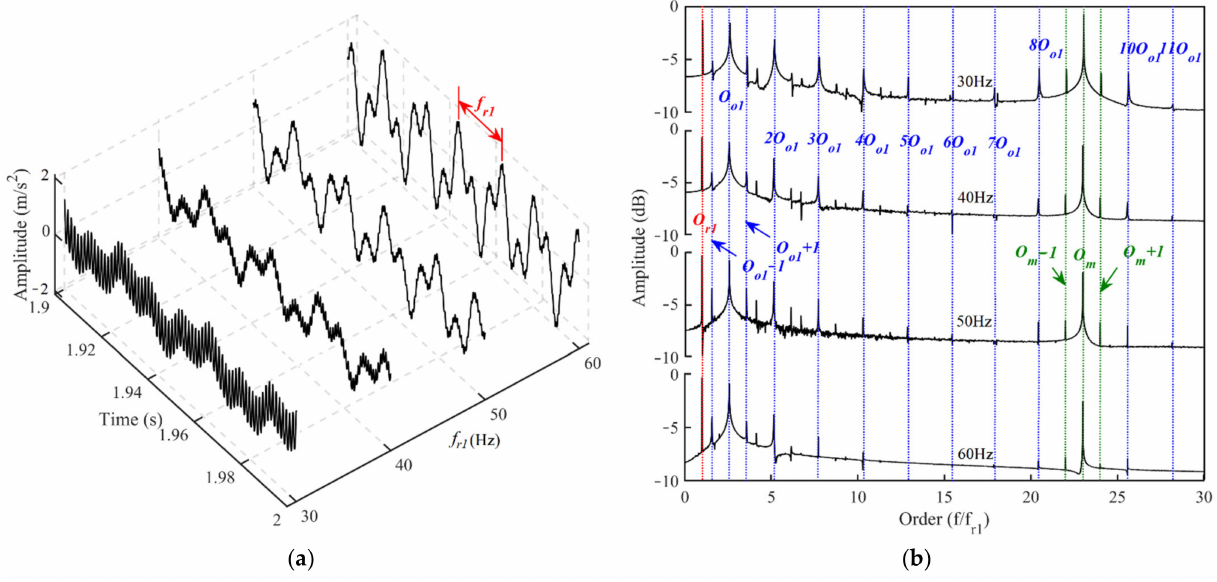
Figure 10. Influence of speed on vibration characters of the bearing-rotor-gear system: ( a ) acceleration response; ( b ) frequency